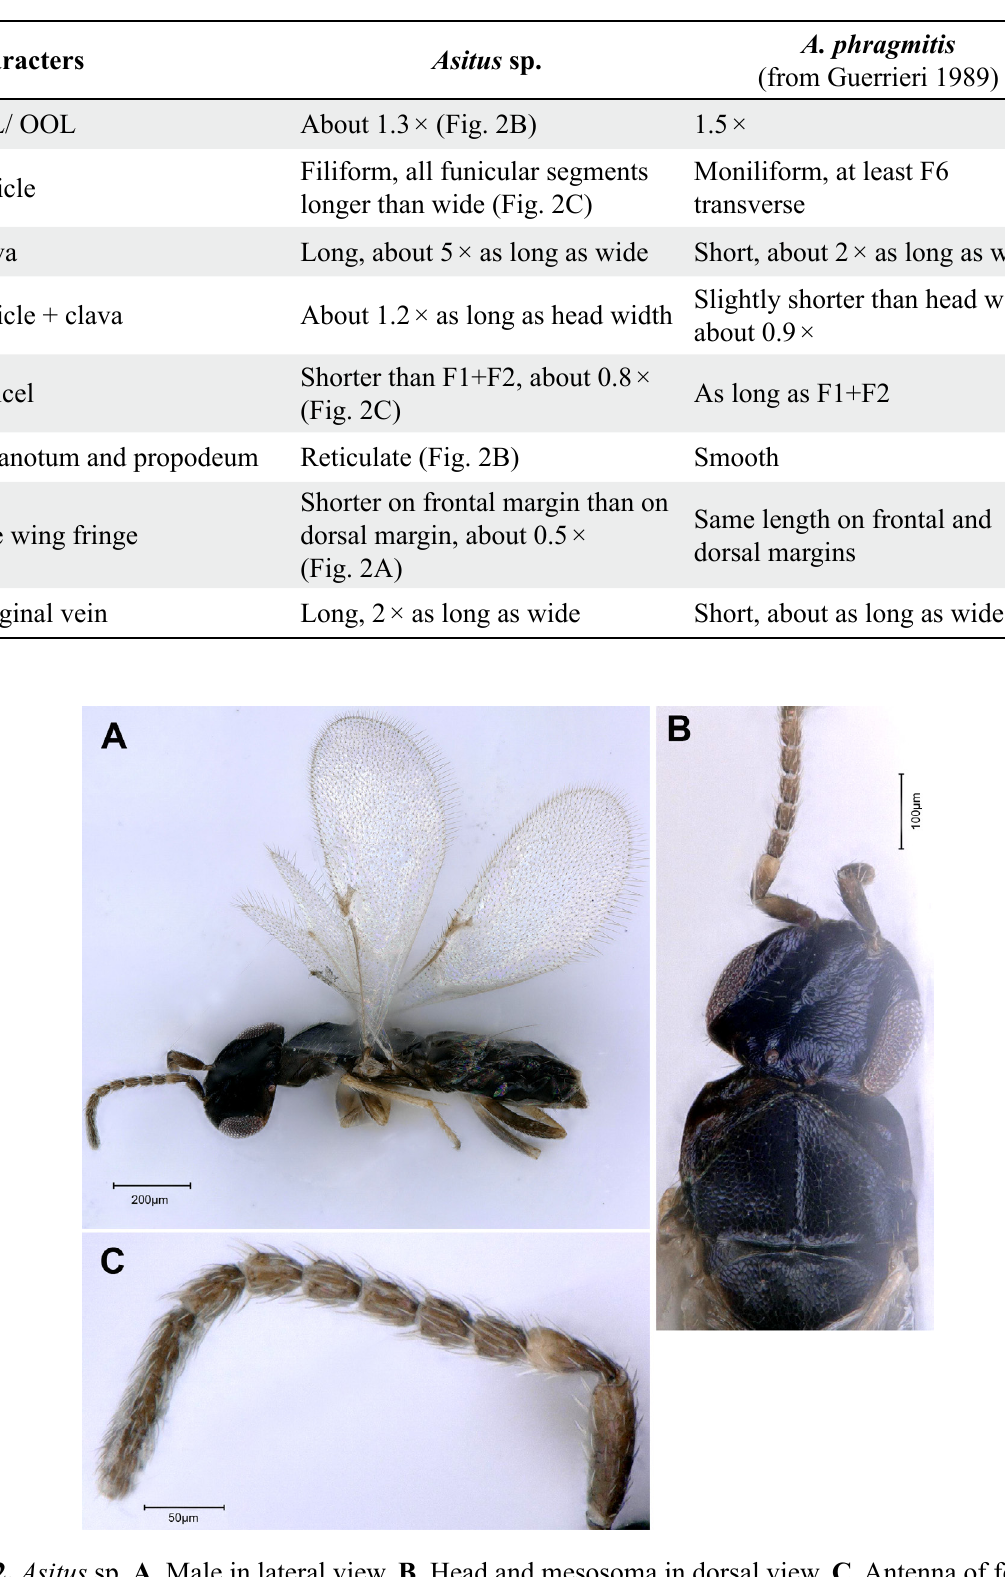
Fig. 2. Asitus sp . A . Male in lateral view. B . Head and mesosoma in dorsal view. C . Antenna of